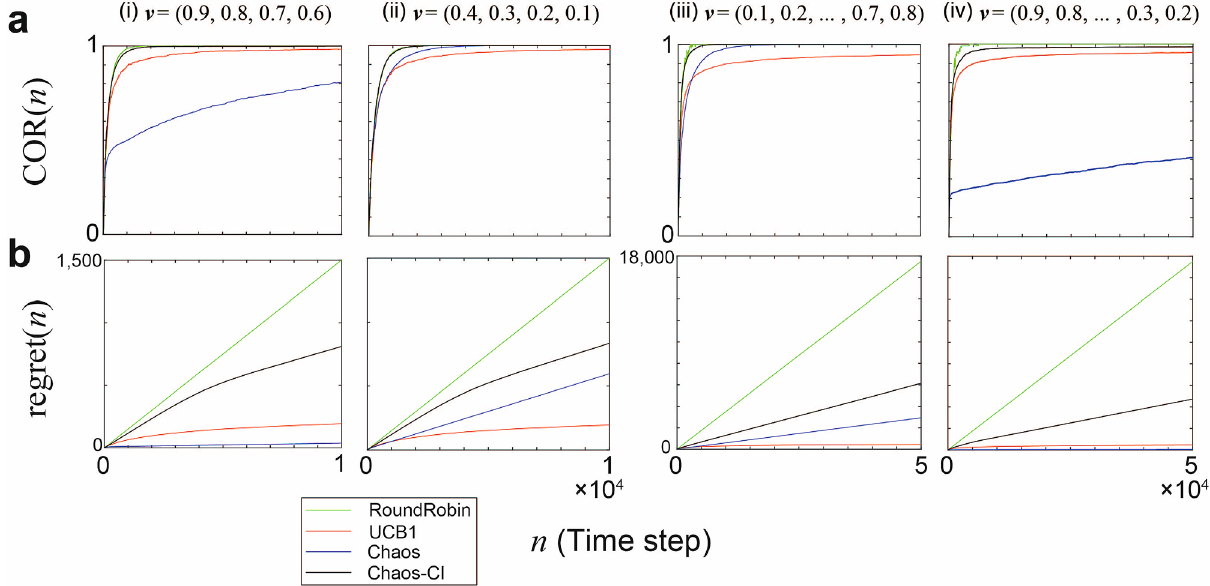
Figure 2. Time evolution of metrics COR ( n ) and regret ( n ) under one reward environment ν . Each column shows the results under each environment: the left two columns are in the four-armed bandit and the right two columns are in the eight-armed bandit. ( a ) COR ( n ) calculated as Eq. (6). ( b ) regret ( n ) calculated as Eq.